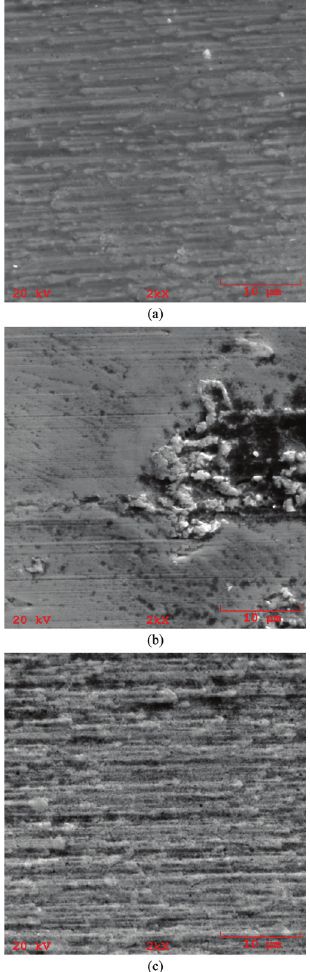
Figure 14. SEM micrographs referring to the wear tracks of AISI H13 samples: a) plasma nitrided b) gas nitrided c) solid nitrided